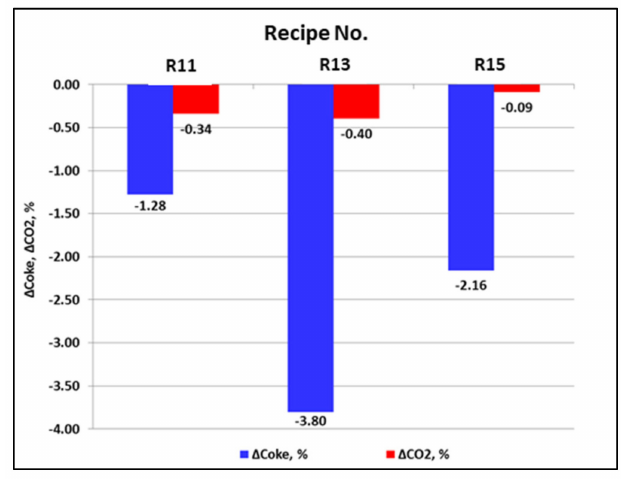
Figure 11. Changing of coke and CO 2 emissions at different cases of developed briquettes.